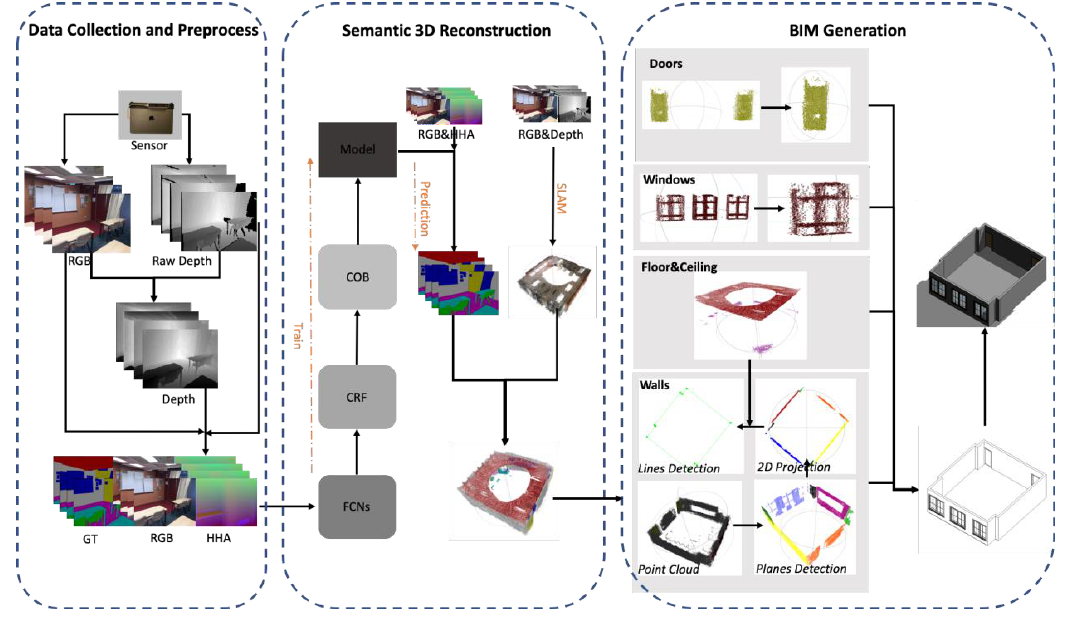
Figure 1. Three stages of automatic building information models (BIM) generation by using a low-cost RGB-D sensor.